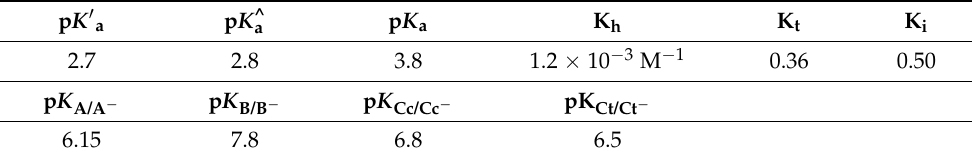
Table 1. Equilibrium constants of